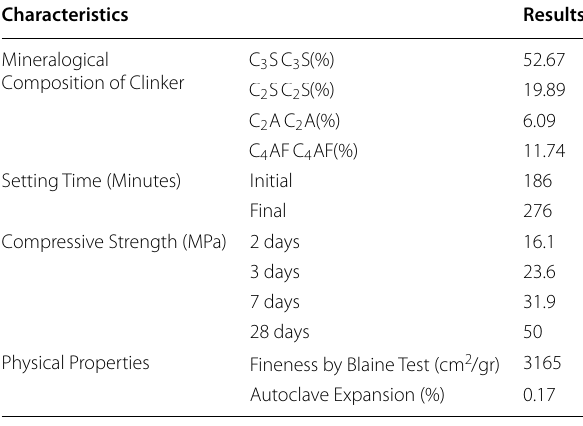
Table 1 Characteristics of the cement.